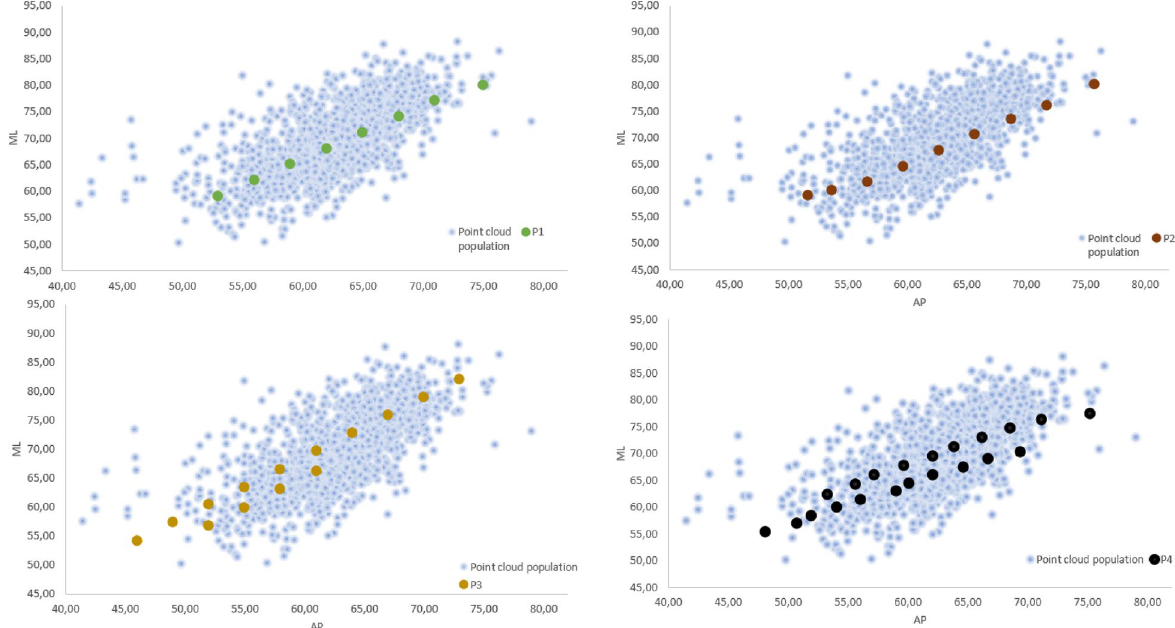
Fig. 3 Comparison of the ML and AP dimensions of the population datapoints and OFT